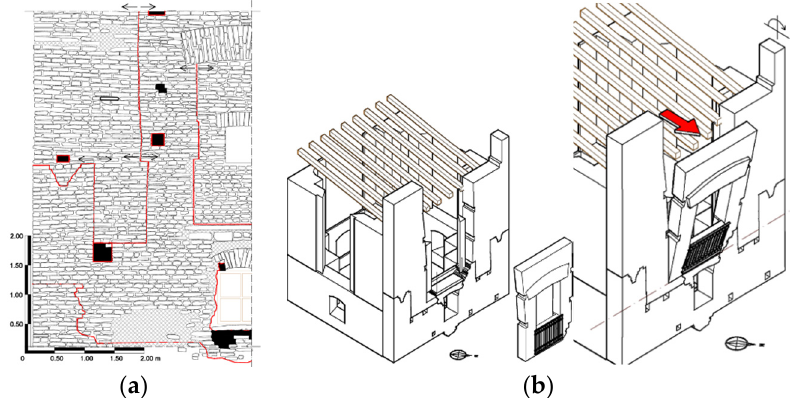
Figure 4. ( a ) Identification of weakly restrained masonry portions and ( b ) potential overturning mechanisms associated to seismic events.